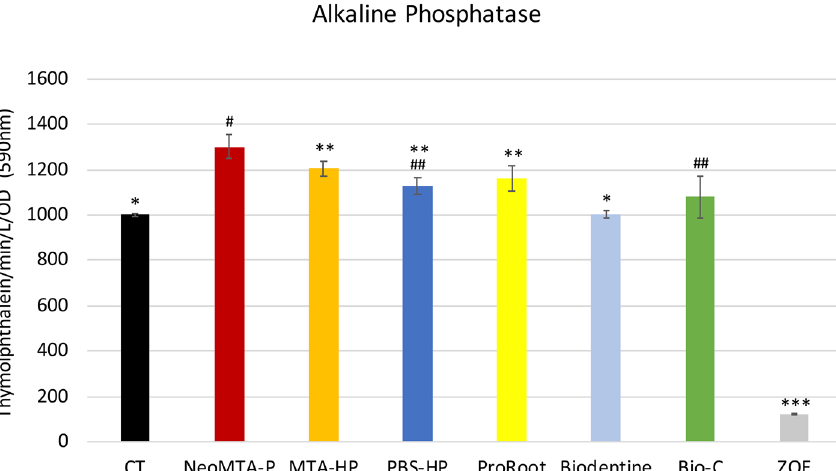
Figure 4. Alkaline phosphatase activity (ALP). The osteoblastic cells showed significantly high ALP activity after exposure to the reparative cements NeoMTA-P, MTA-HP, PBS-HP, ProRoot, and Bio-C compared to the control group (CT). Only Biodentine was statistically similar to the CT. Data are presented as mean ± SD; one-way ANOVA, followed by multiple comparisons post-hoc test with Bonferroni’s test. Symbols on the chart indicate homogeneous groups by Bonferroni’s posttest. *p < 0.01, all groups versus CT; # p < 0.001, NeoMTA-P versus all groups; **p < 0.02, MTA-HP versus all groups; ## p < 0.02, PBS-HP versus all groups; and ***p < 0.001, ZOE versus all